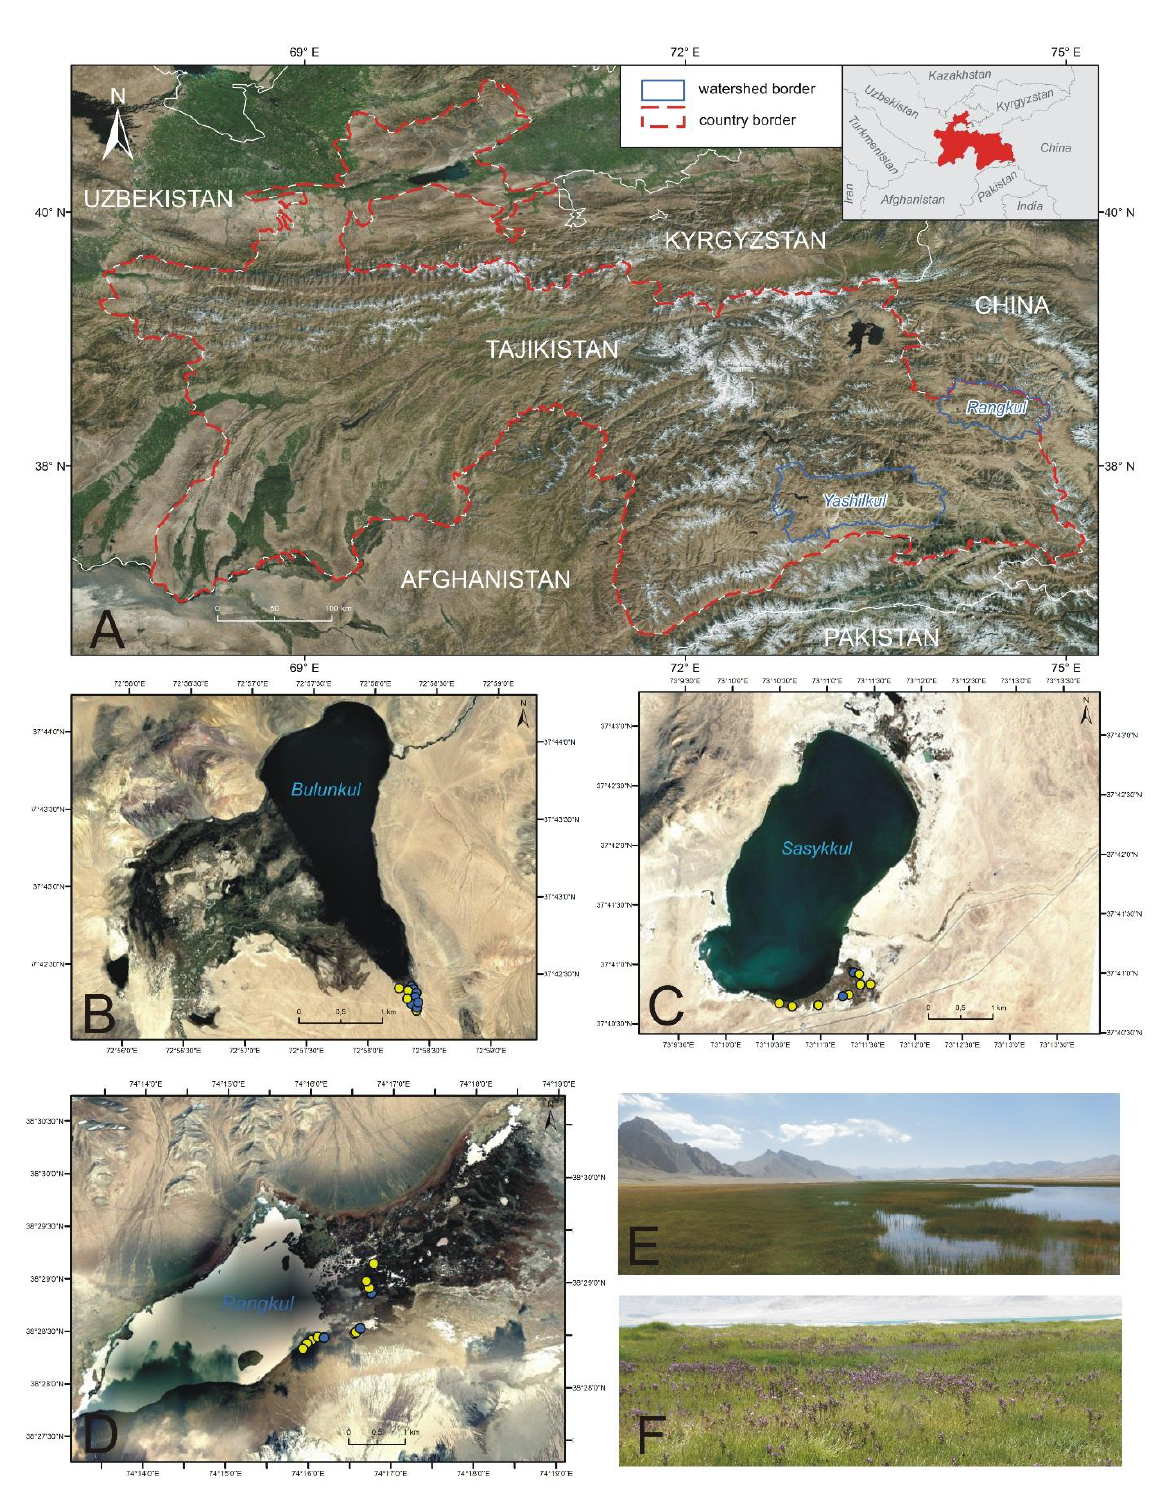
Figure 1. A: Locations of the Yashilkul and Rangkul/Shorkul catchments in the Eastern Pamir, Tajikistan. B–D: Locations of study sites on the terraces of Lakes Bulunkul (B), Sassykul (C) (both in the Yashilkul catchment) and Rangkul (D) (Rangkul/Shorkul catchment); blue dots = salt marsh, yellow dots = saline small sedge meadow. E: Salt marsh dominated by Blysmus rufus . F: Saline small sedge meadow dominated